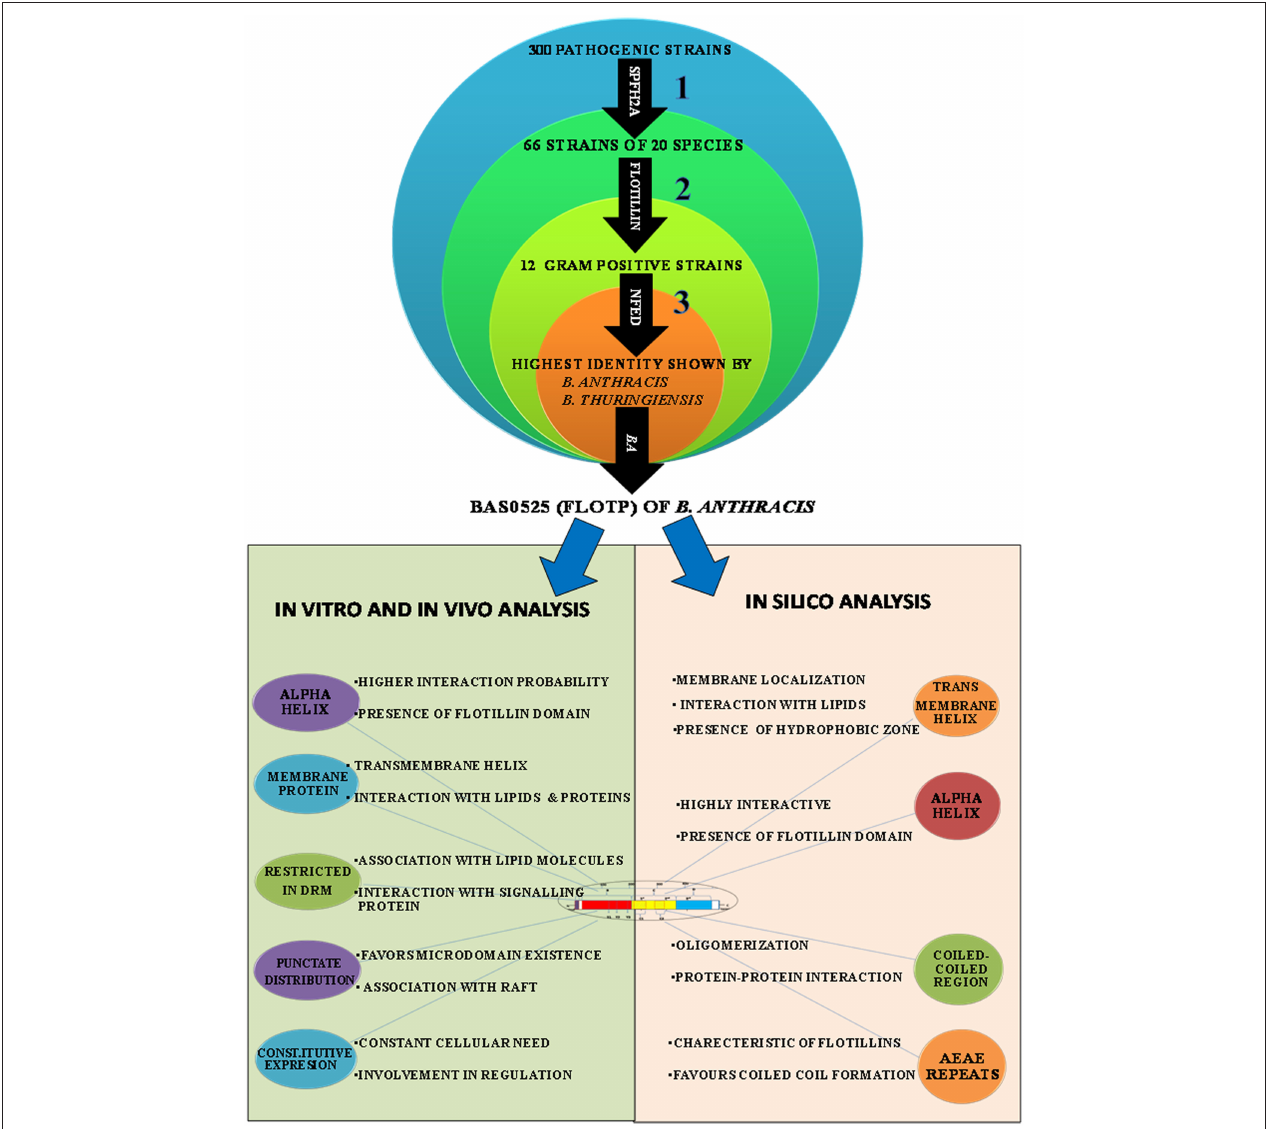
FIGURE 7 | Graphical representation of the highlights (strategies used at different steps and outcome) of this study. In silico , in vitro, and in vivo approaches were employed for characterization of FlotP, an eukaryotic Flotillin homolog. Numericals represent the different steps of study; bold arrows indicate the domains used for the basis of homology